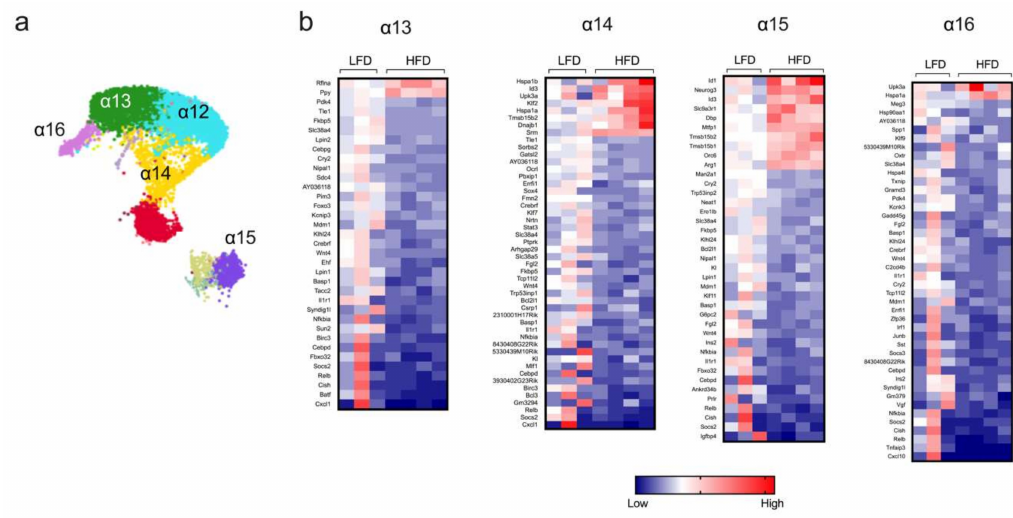
Figure 4. Transcriptome profile in α -cell clusters identified by single-cell RNA sequencing. α -cell clusters were identified following single-cell RNA sequencing from male C57BL / 6J mice fed for one week with either a high-fat diet (HFD, 60% kcal from fat) or a control low-fat diet (LFD, 10% kcal from fat). ( a ) Representative UMAP plot of α -cell clusters; ( b ) heatmaps depicting genes di ff erentially regulated ( p < 0.05) in α -cell clusters; genes are ordered from most positive to most negative